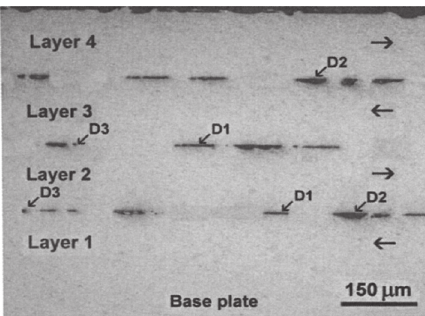
Figure 7: Microstructure of Al3003 showing line (D1), parabolic (D2), and point defects (D3)